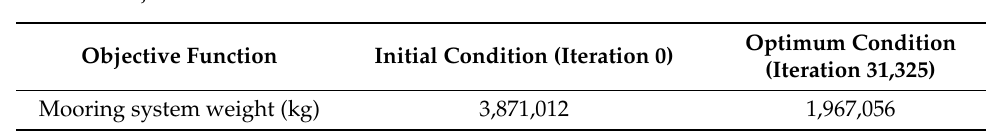
Table 10. Objective function results for case